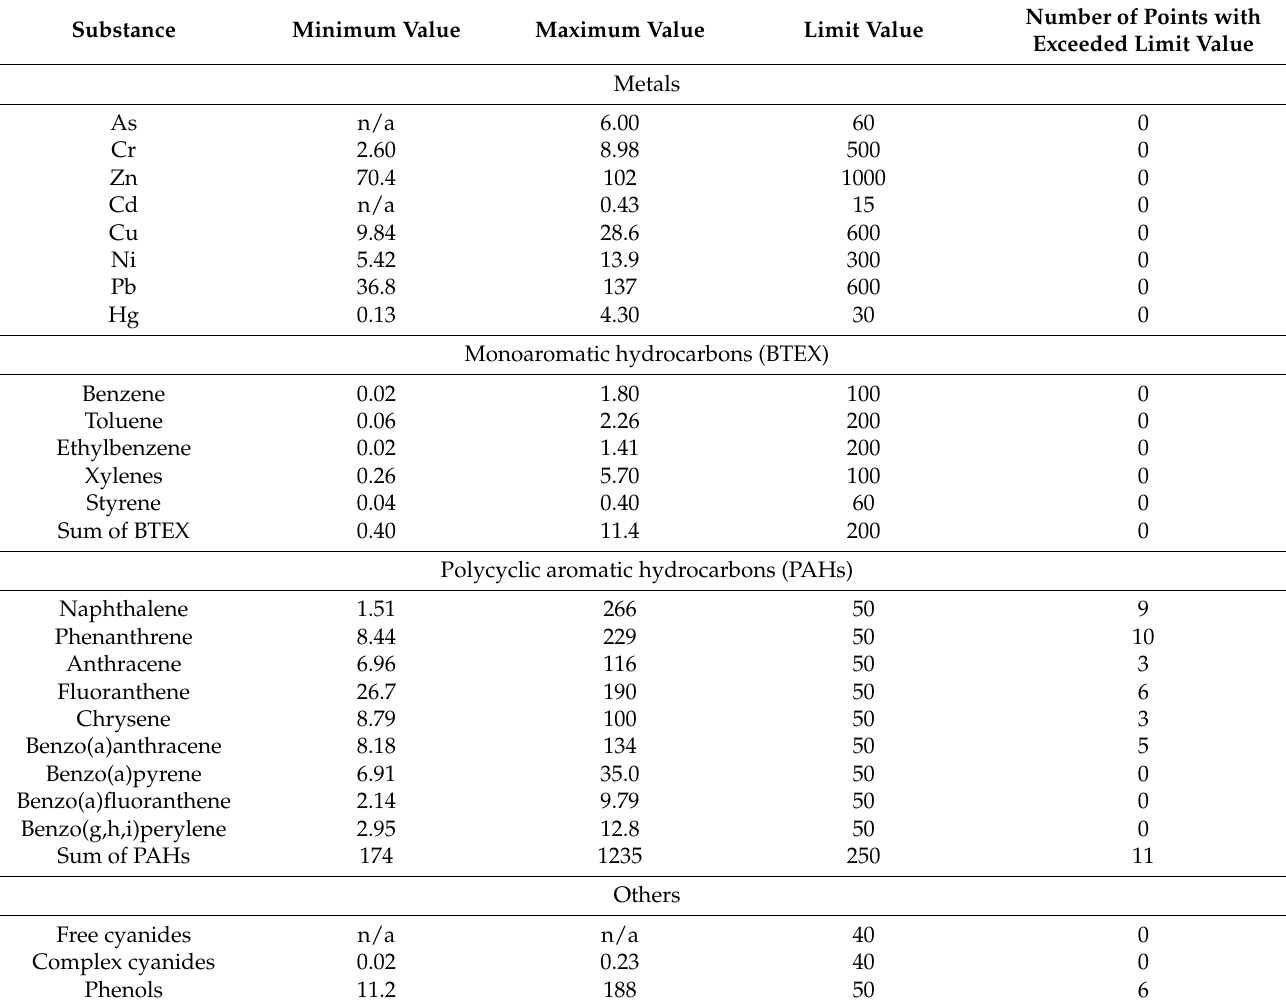
Table 1. The lowest and highest contents of pollutants determined in the soil from the industrial wasteland prior to remediation, based on the permissible Polish standards for industrial areas (mg kg − 1